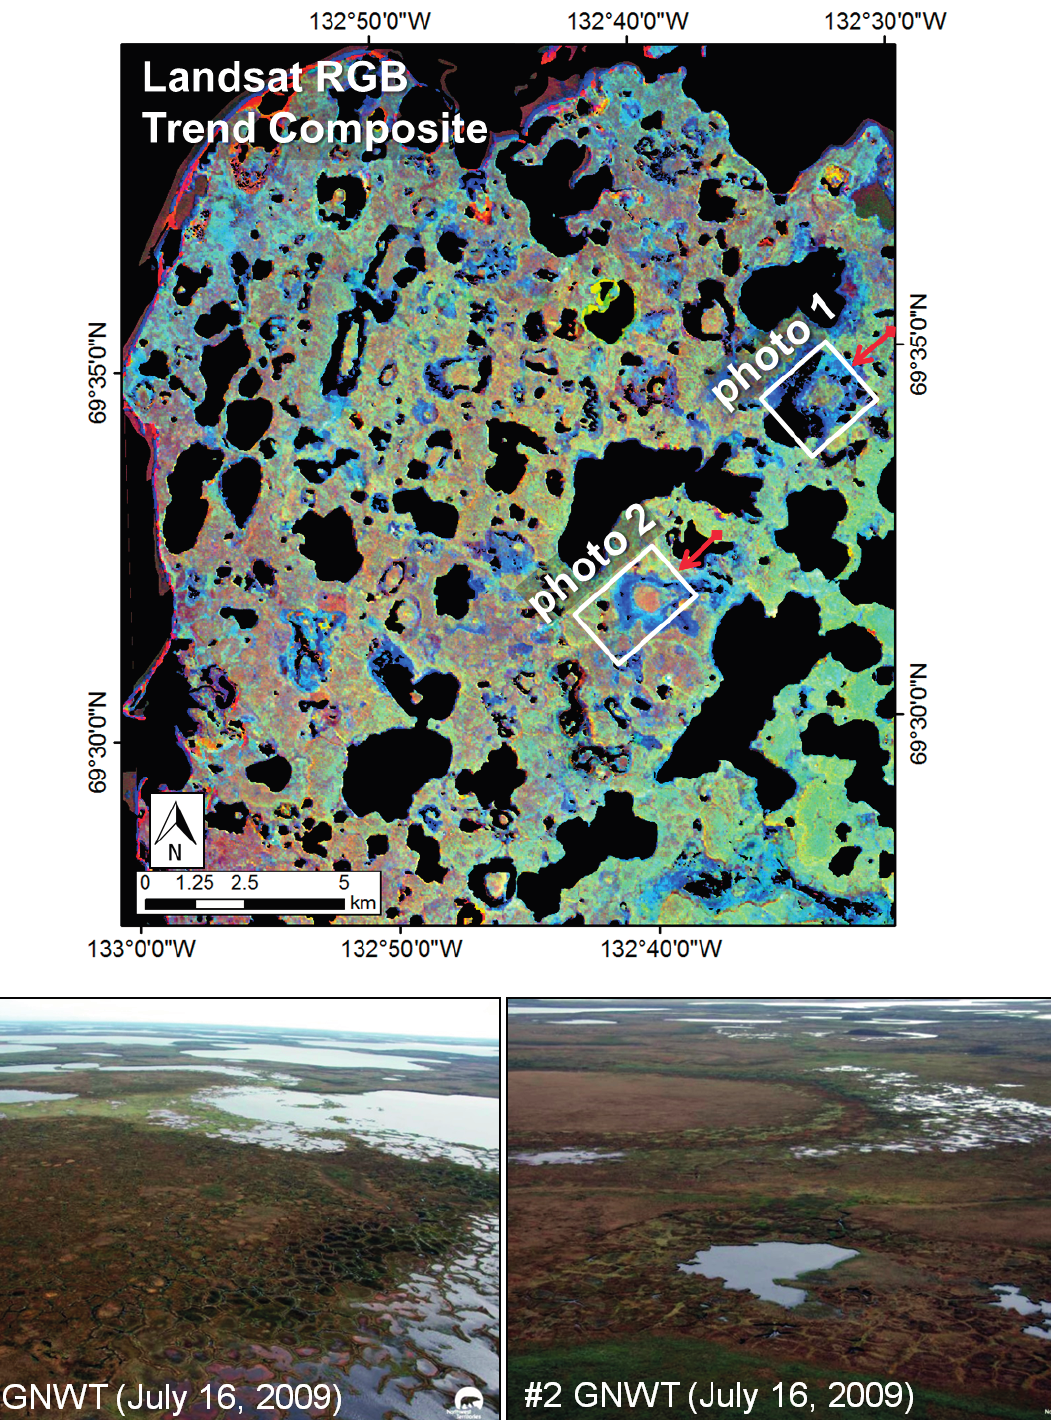
Figure 8. Area east of Tuktoyaktuk showing widespread increases in wetness in the trend image ( top ) over ice-wedge polygon terrain (dark blue), some expanding lakes (dark blue), and eroding coastline (dark blue and red). Areas of surface ponding can be observed in recent oblique air photos captured by the NWT Government ( bottom ). The red arrows show the direction from which the photos were